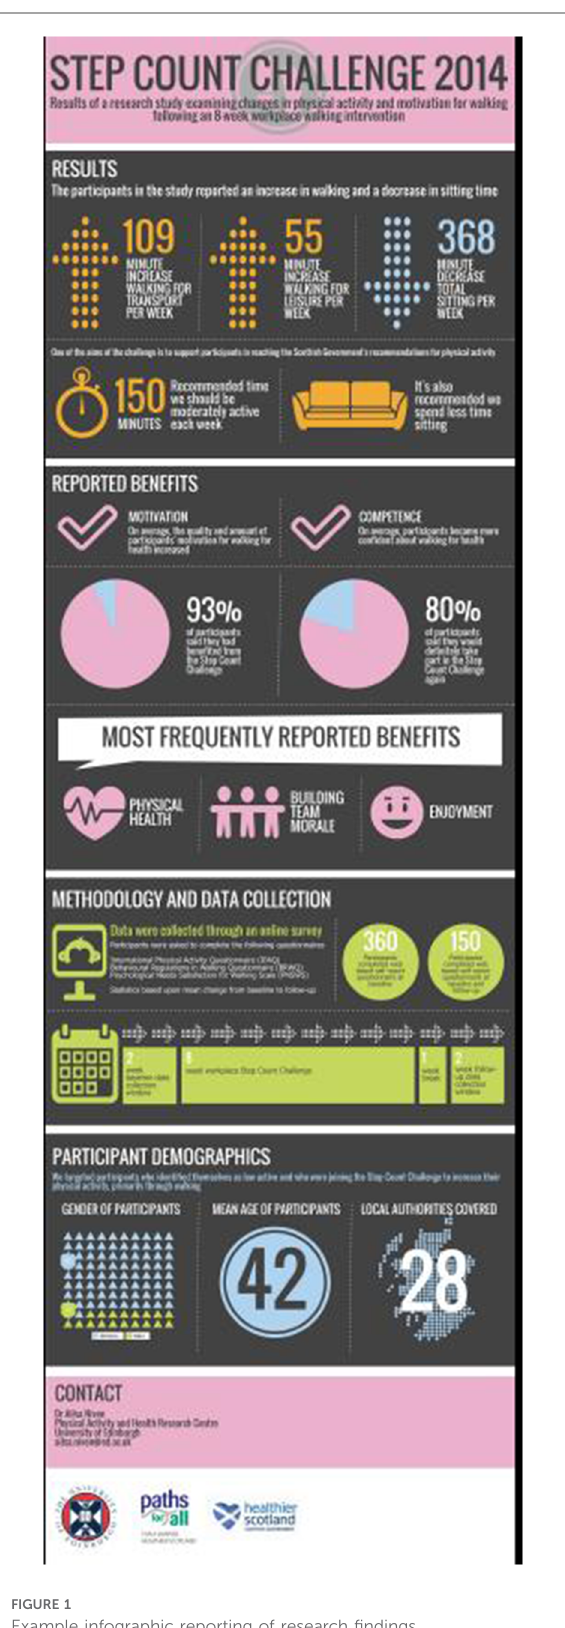
FIGURE 1 Example infographic reporting of research fi